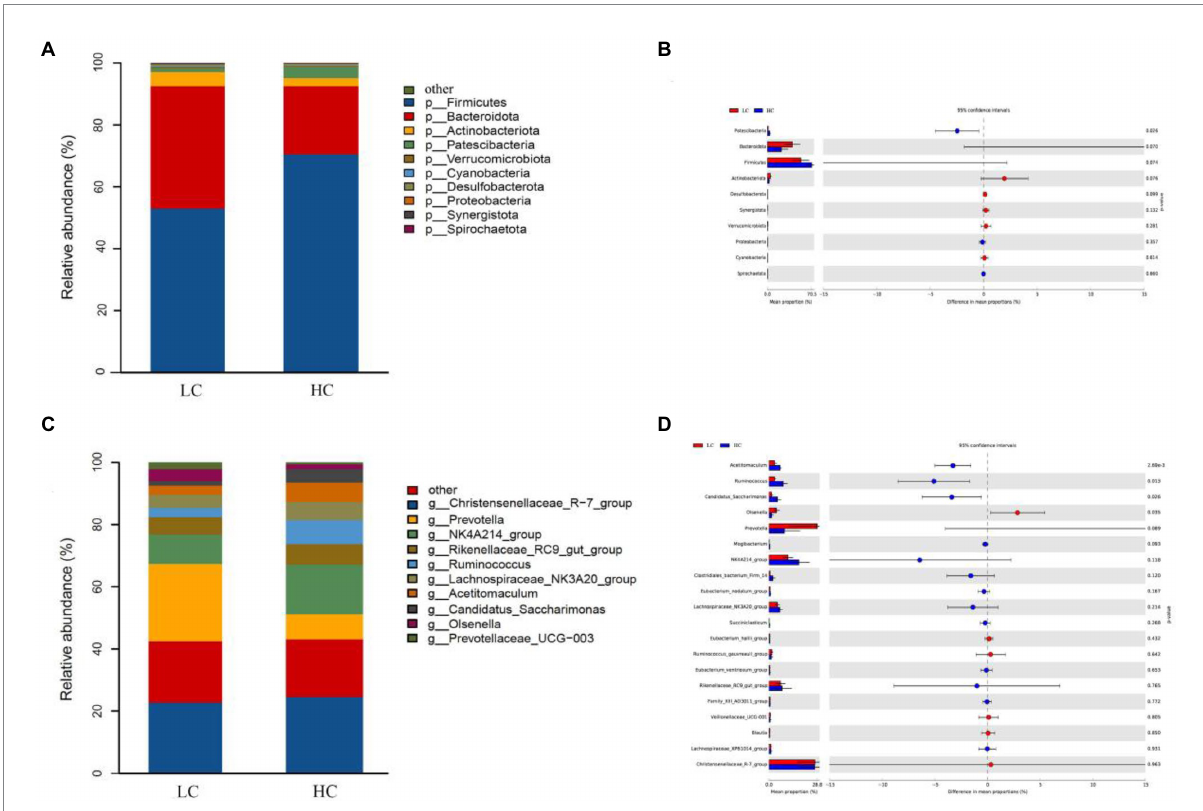
FIGURE 3 Classification of bacterial community composition in yaks fed low concentrate (LC) and high concentrate (HC) diets. (A) Phylum level. (C) Extended error bars showing the bacteria that differed between the two groups at the phylum level. (B) Genus level. (D) Extended error bars showing the two groups of bacteria that differed at the genus level.